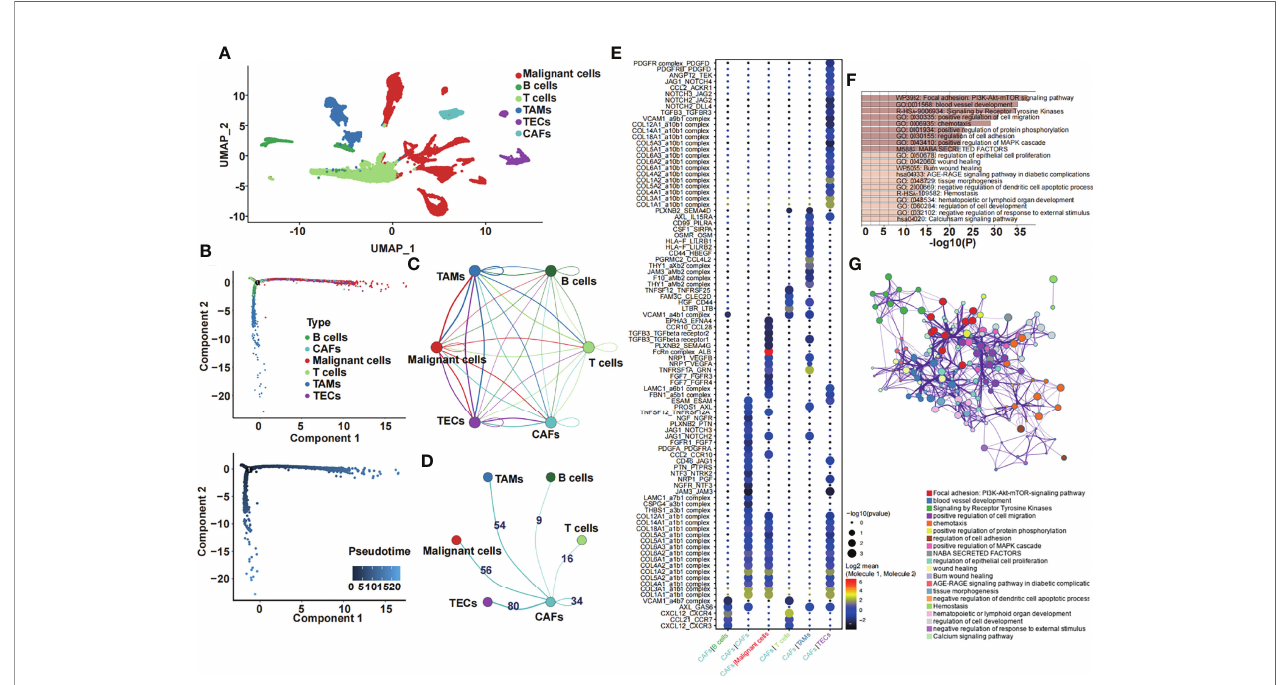
FIGURE 1 | Single-cell transcriptome analysis and the function of CAF-related genes. (A) The six cell subclusters are shown. (B) Pseudotime analysis of six cell subclusters was performed. (C) The ligand – receptor interaction network among six subclusters is shown. (D) The number of ligand – receptor pairs between CAFs and other subclusters is shown. (E) The speci fi c ligand – receptor pair between CAFs and other subclusters is shown. (F) Enrichment analysis of the differentially expressed CAF-related genes. (G) The corresponding network of the enrichment analysis of the differentially expressed CAF-related